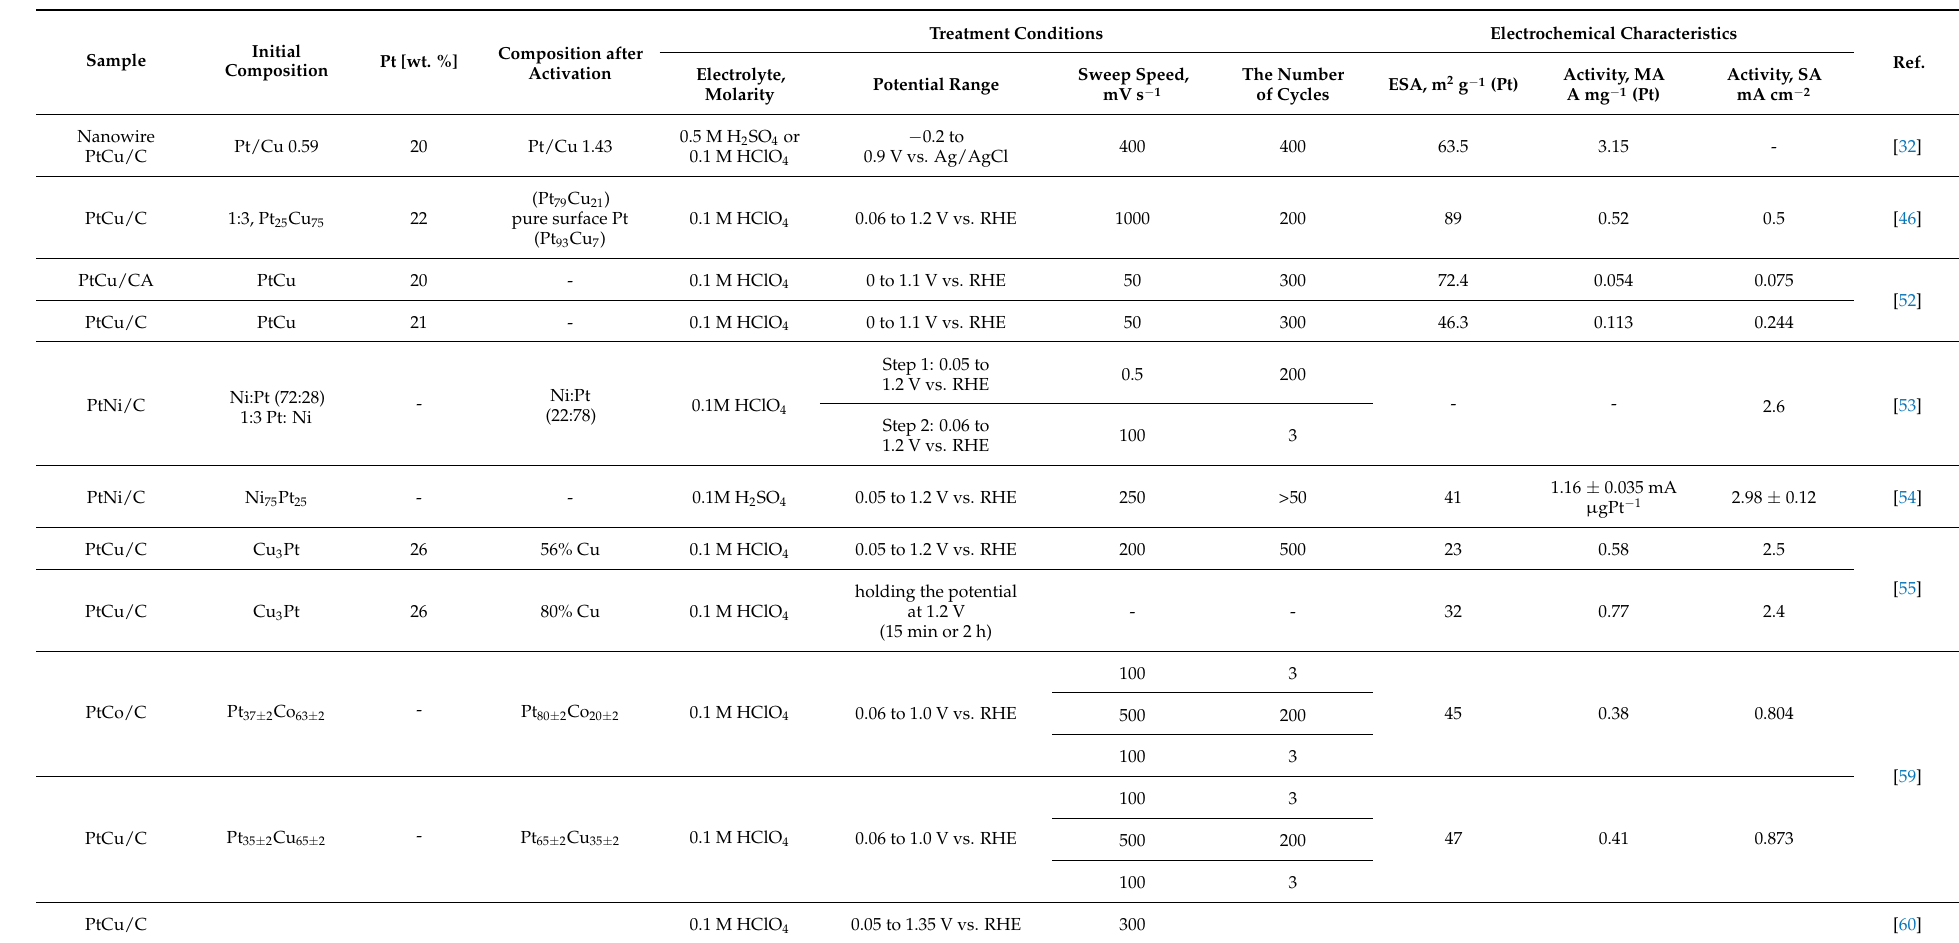
Table 2. Structural and electrochemical characteristics of bimetallic catalysts after electrochemical